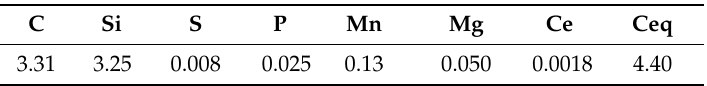
Table 1. Final chemical composition (wt